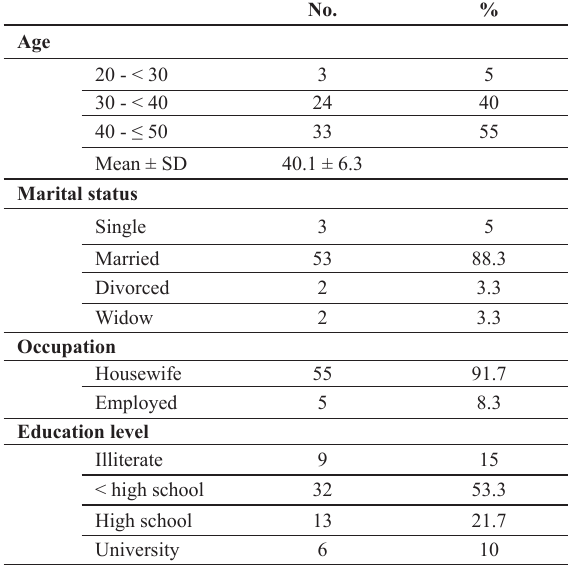
Table 1: Socio-demographic characteristics of patients